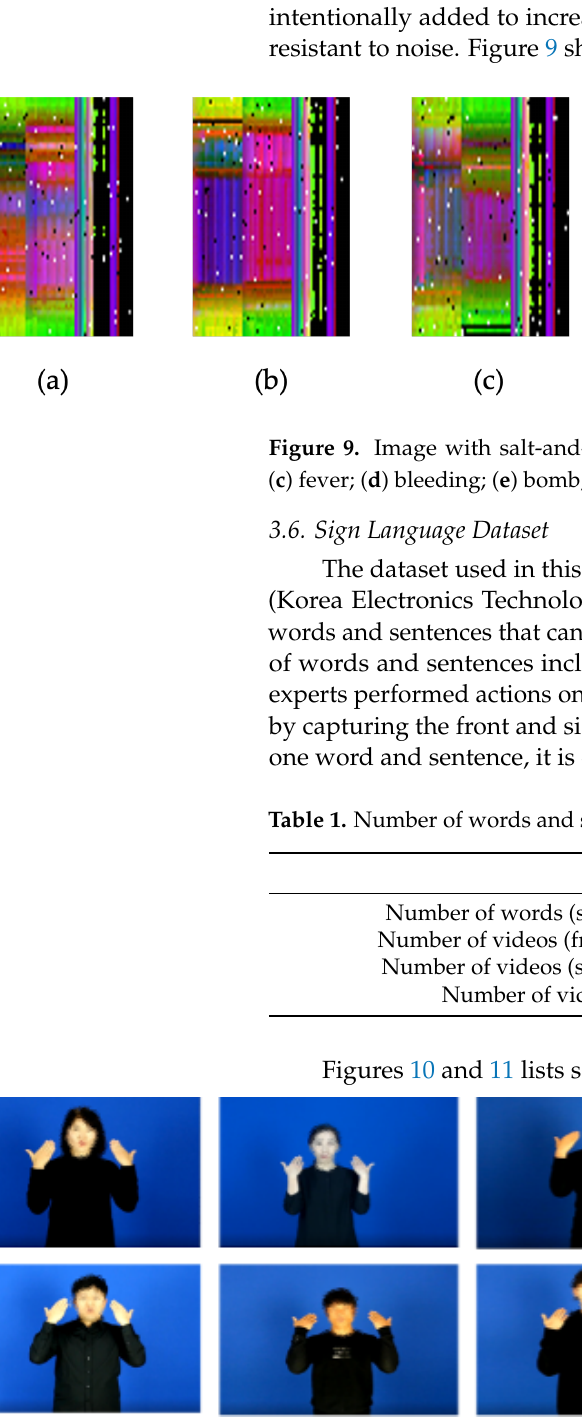
Figure 10. Examples of sign language datasets representing "school" word performed by 10 signers in the front